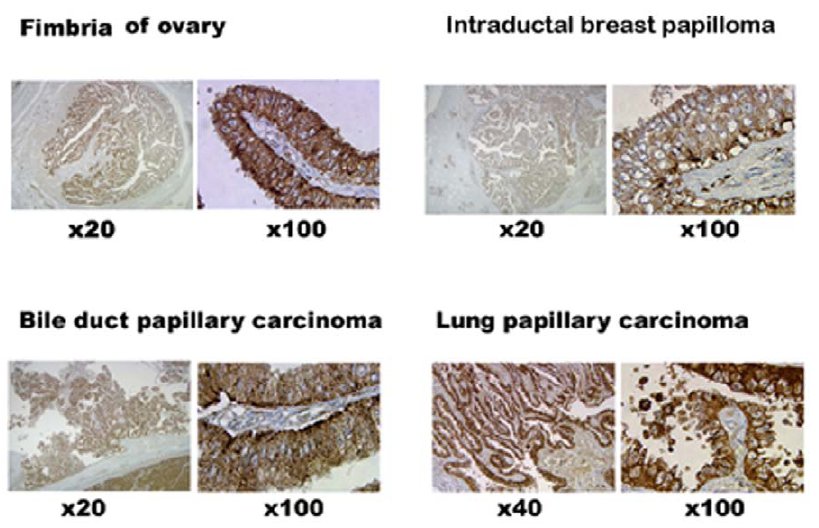
Figure 1. NPC2 protein expression in human papillary tissues. Immunohistochemical stain showed the presence of cytoplasmic NPC2 protein (brown color) in surgical samples of human papillary tissues. All papillary tissues have open spaces outside of papillary projections. The numbers indicate the degree of the magnification.